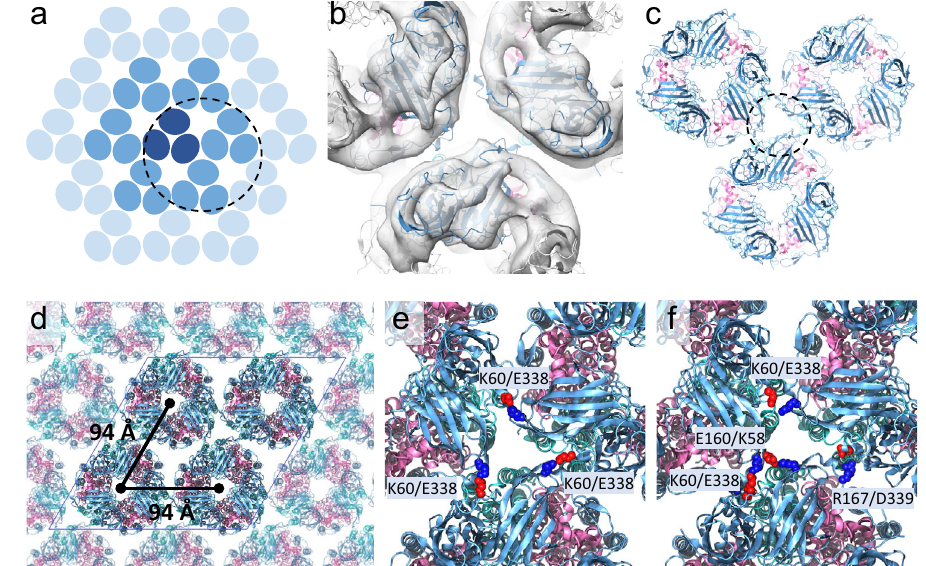
Fig. 4 | Higher-order assembly of pMMO trimers. a A schematic of the pMMO trimer hexagonalarray. Eachblue ovalrepresentsa pMMO monomerconsisting of PmoA, PmoB, and PmoC. The central pMMO trimer (dark blue), together with 6surroundingtrimers(mediumblue),representthe7-particleunitshowninFig.1g and Fig. 2b. b CryoET STA of the subvolumes enclosing an inter-trimer interface, shown as a circled unit in ( a ), superimposed with docked pMMO model. ( c ) Structural model of pMMO trimer assembly. The inter-trimer interaction is